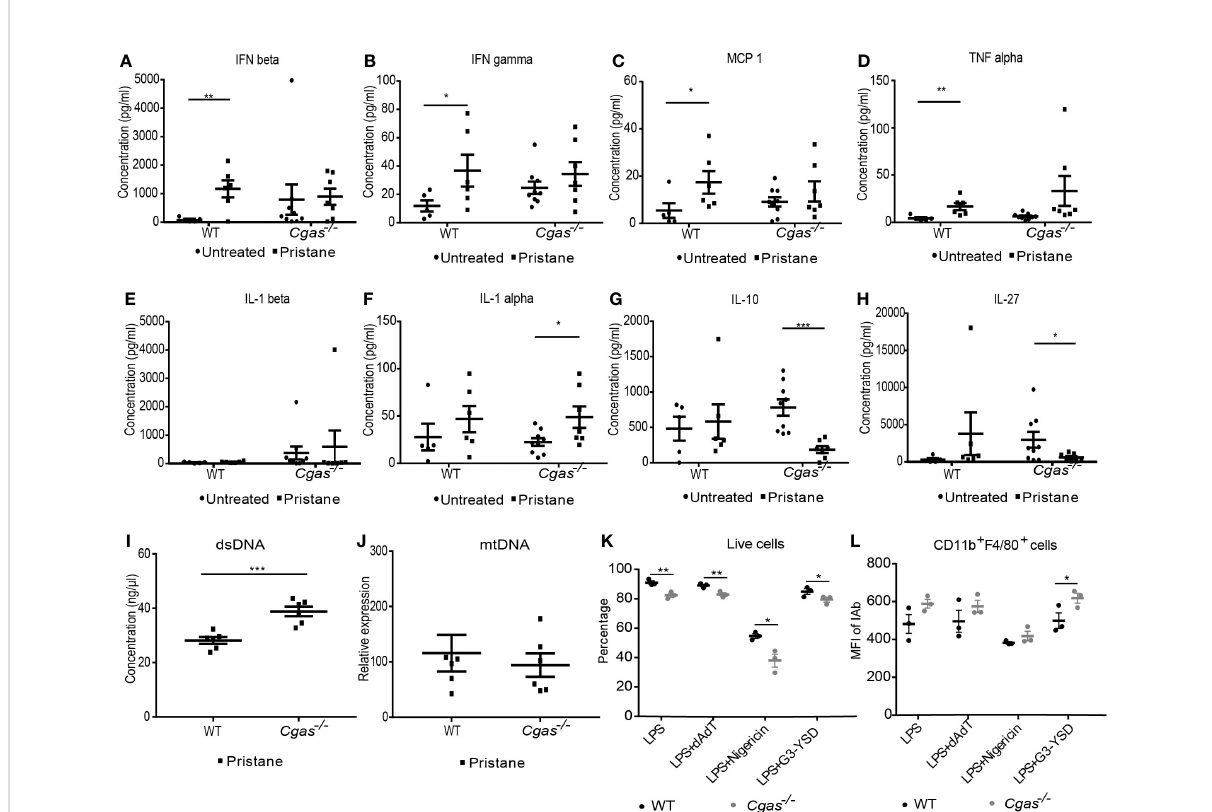
FIGURE 6 The absence of cGAS induces in fl ammasome activation. (A – H) The cytometric bead array analyzed the serum cytokines of WT and Cgas -/- mice at 8 months after pristane injection. Serum cytokines (A) IFN- b , (B) IFN- g , (C) MCP-1, (D) TNF- a , (E) IL-1 b , (F) IL-1 a , (G) IL-10, and (H) IL-27 (n = 5-9 per group). (I) The dsDNA level from the spleen of WT and Cgas -/- mice at 8 months after pristane injection (n = 6 per group). (J) The Quantitative real-time PCR analysis of mitochondrial DNA (mtDNA) (normalized to b -2-microglobulin) from the spleen of WT and Cgas -/- mice at 8 months after pristane injection (n = 6 per group). Bone marrow-derived macrophages (BMDMs) were differentiated with M-CSF1 for 7 days. Flow cytometry analysis shows the percentage of live cells (K) and the mean fl uorescence intensity of CD11b + F4/80 + IAb + cells (L) after dAdT, nigericin, and G3-YSD activation for 24 hours (n = 3 mice per group). Data are shown as the mean ± SEM. *p < 0.05, **p < 0.01, *** p <